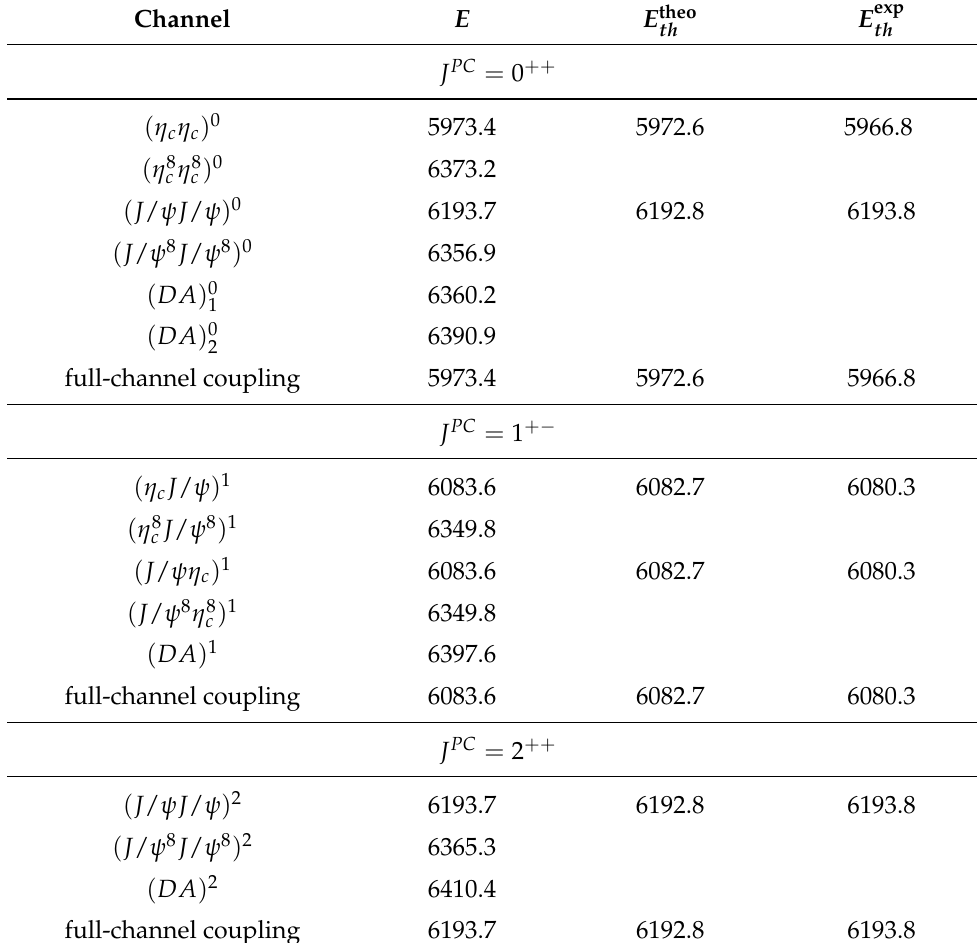
Table 4. The low-lying energies of the cc ¯ c ¯ c states with J PC = 0 ++ , 1 + − , 2 ++ in single channel and full-channel coupling calculations. E theo thresholds, respectively (unit: